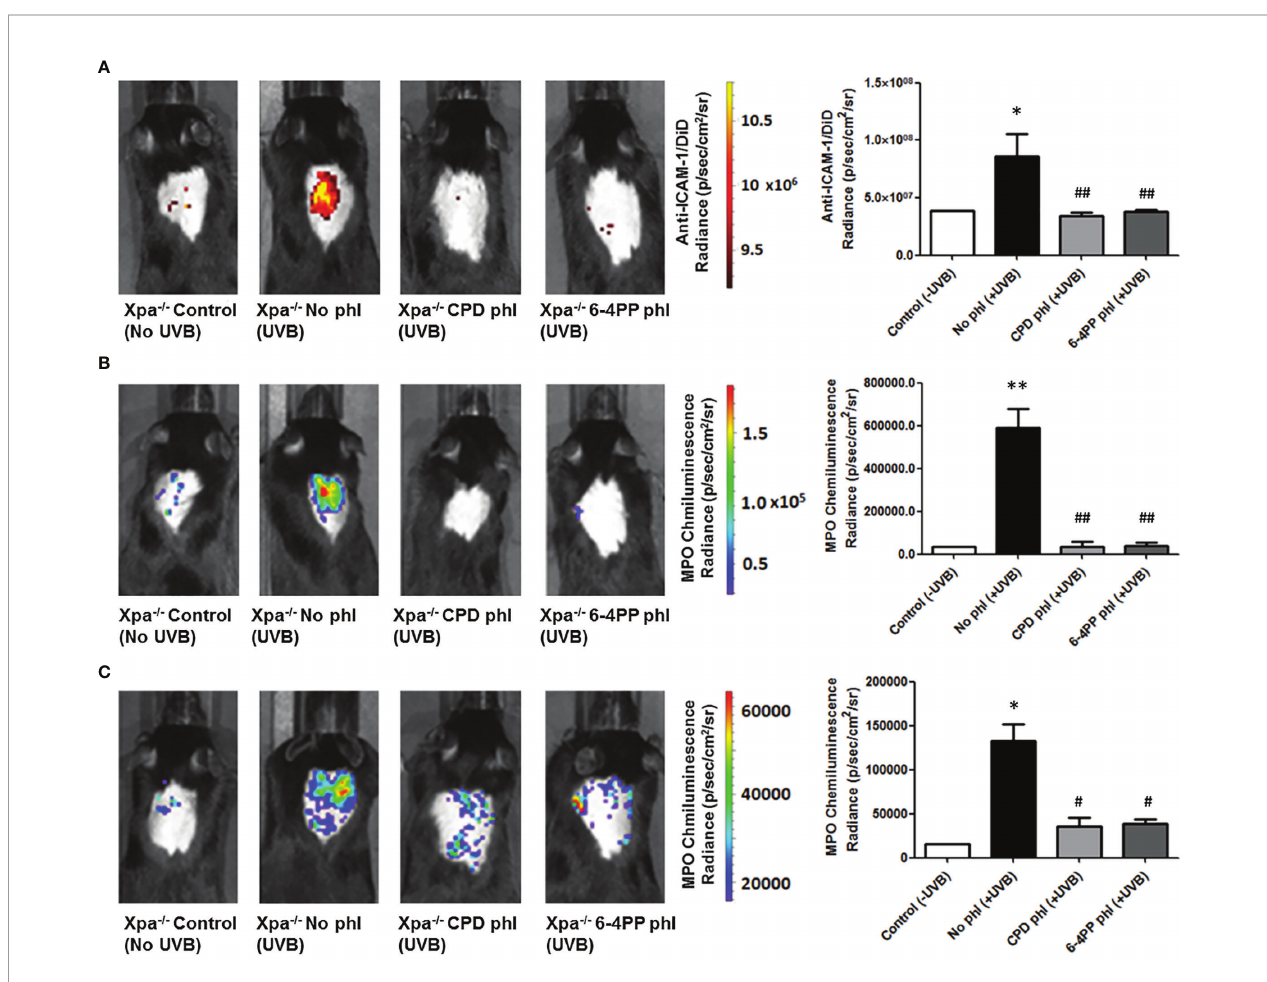
FIGURE 3 | Leukocyte in fi ltration and activation in vivo imaging of Xpa-/- mice expressing CPD or 6-4PP-photolyase in basal keratinocytes. (A) In vivo imaging of ICAM-1, an in fl ammation marker, coupled to a DiD fl uorophore containing nanoparticle. Imaging was performed in photolyase (CPD- or 6-4PP-phl) expressing Xpa-/- mice 6 h after irradiation with 200 J/m2 UVB, n = 4. (B, C) MPO, an active neutrophil marker, was measured in vivo 6 (B) and 24 h (C) after UVB radiation of Xpa-/- mice by using a chemiluminescent probe, n = 2. Radiance and luminescence were measured using Living Image 4.0 software. Asterisks (*) indicate a statistically signi fi cant difference between the designated group and the negative, Xpa-/- non-irradiated, controls, while the pound signs (#) indicate a signi fi cant difference between the designated group and the positive control group, Xpa-/- mice with no photolyase UVB-irradiated. “ * ” or “ # ” : p<0.05, “ ** ” or “ ## ” :